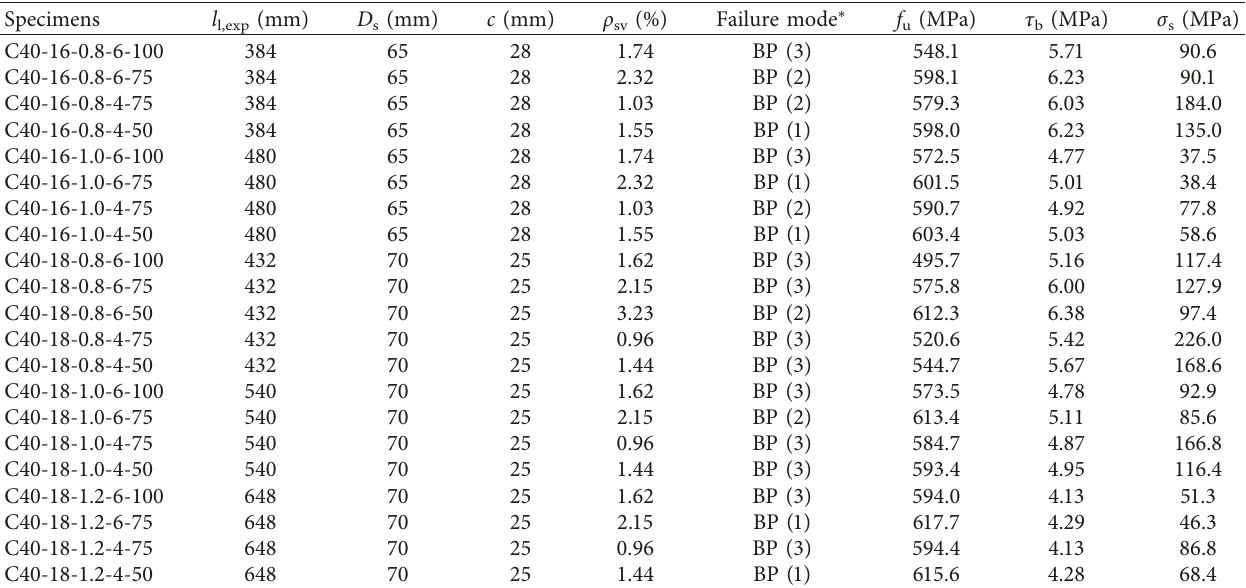
Table 3: Calculated tensile stress of spiral